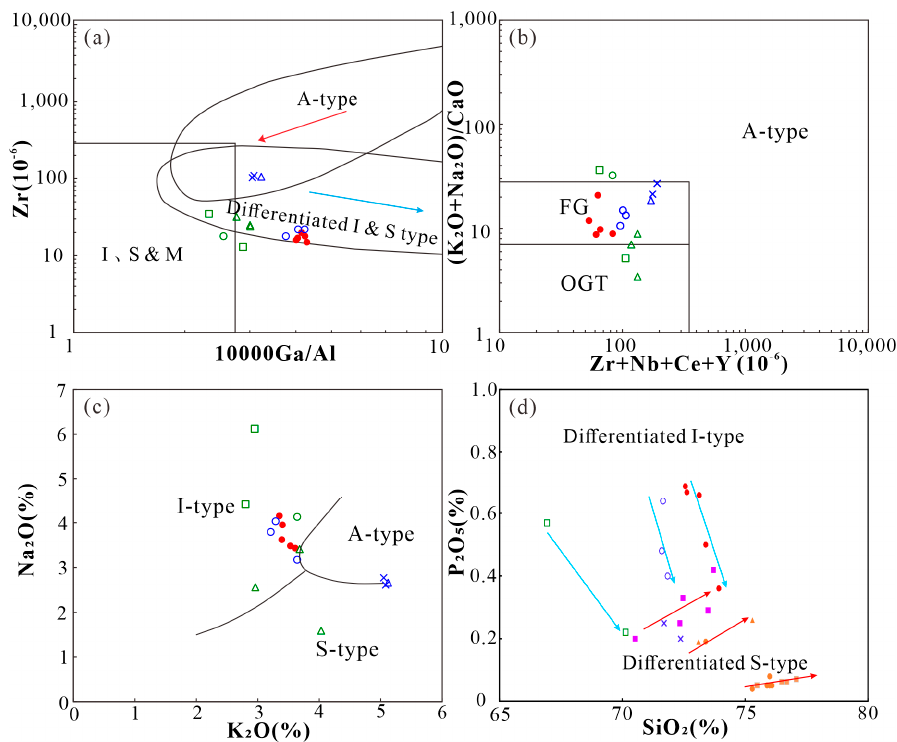
Figure 6. Discrimination diagrams of the petrogenesis type for the Dongcao muscovite granite: ( a ). Zr vs. Ga/Al discrimination diagram (the base map is derived from [39]); ( b ). (K 2 O + Na 2 O)/CaO vs. (Nb + Zr + Ce + Y) discrimination diagram (the base map is derived from [46]); ( c ). Na 2 O vs. K 2 O discrimination diagram (the base map is derived from [47]); ( d ). P 2 O 5 vs. SiO 2 discrimination dia- gram (the base map is derived from [48]). (Legend description: the red dots are data of the Dongcao muscovite granite samples in this paper; the blue crosses are data of the Dagang protolothionite muscovite granite; the blue triangles are data of the Dagang pegmatitic dike; and the blue circles are data of the Dagang lepidolite alkali–feldspar granite [8]; the green circles are data of the Baishuidong Li–rich muscovite granite; the green rectangles are data of the Baishuidong trilithionite granite; and the green triangles are data of the Baishuidong aplite [7]; the purple rectangles are data of di ff eren- tiated S − type granite [44]; the orange circles are data of Tieshanlong porphyroid biotite granite; the orange rectangles are data of Tieshanlong two − mica granite; and the orange triangles are data of Tieshanlong granite porphyry [45].). Studies show that Sr tends to enter plagioclase during the evolution of magmatic crystallization di ff erentiation, and the fractional crystallization of plagioclase leads to a decrease in the Sr content and an increase in the Ba/Sr ratio in residual magma. While Ba tends to enter potassium feldspar, the fractional crystallization of potassium feldspar usu- ally leads to a decrease in the Ba content and Ba/Sr ratio in residual magma [37,49]. The Dongcao muscovite granite has noticeable depletions in Ba and Sr, and the lack of Ba is severe. The Ba content in most samples is lower than the detection limit, indicating that they have experienced vital feldspar mineral fractional crystallization in the evolutionary process and mainly potassium feldspar fractional crystallization, which is more consistent with the discrimination results of sample points in the Ba vs. Rb and Rb/Sr vs. Sr discrim- ination diagrams (Figure 7a,b). There is an apparent negative Ti anomaly in the rocks, which is generally believed to be caused by the fractional crystallization of Ti–rich miner- als, such as rutile, ilmenite, and sphene. These minerals are also the main host minerals of Nb and Ta. If apparent fractional crystallization occurs, the Nb and Ta contents in the re- sidual magma are also reduced, contrary to the relative enrichment of Nb and Ta in the